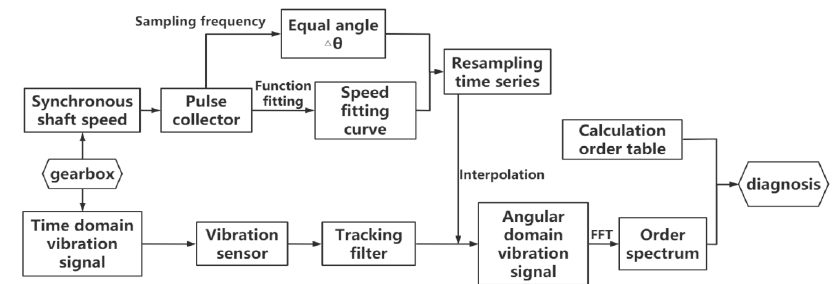
Figure 3. Fault diagnosis flow